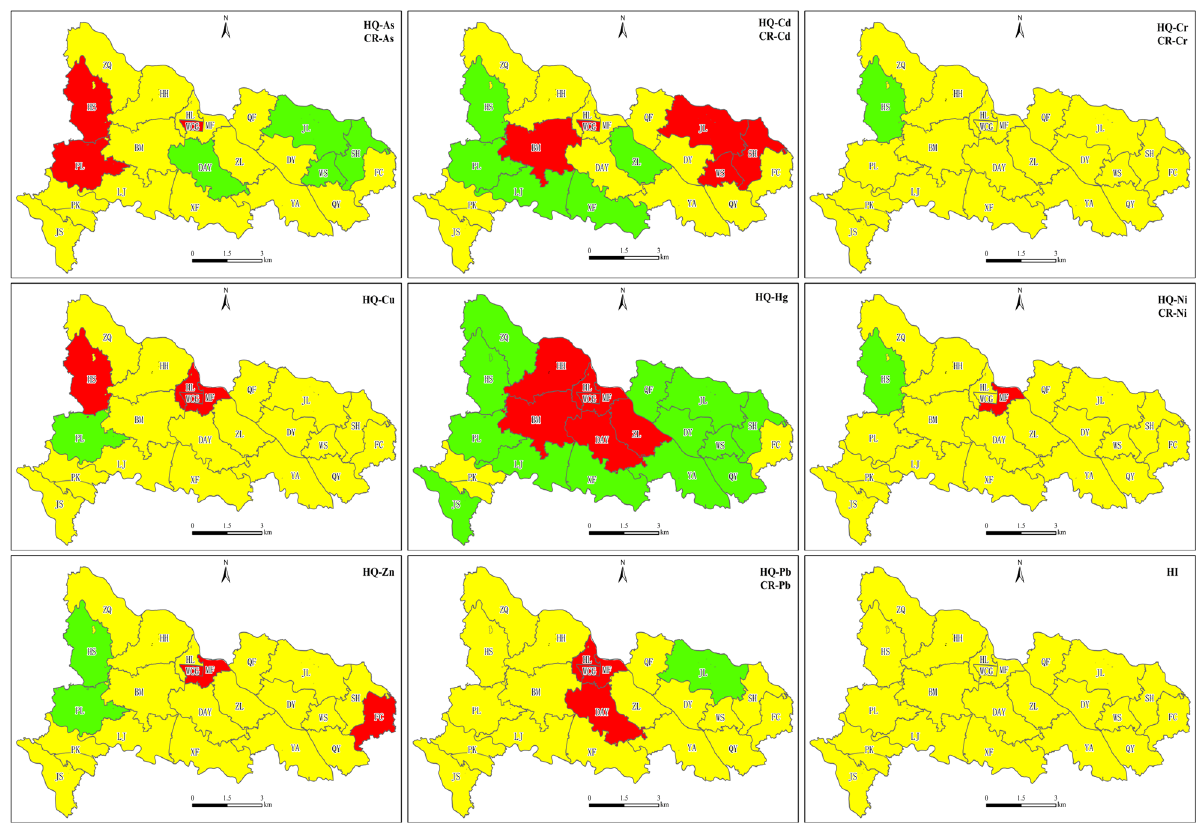
Figure 3. Health risk level of HMs in soil of different sub regions. (Green, yellow and red indicate low-risk level, medium-risk level and high-risk level